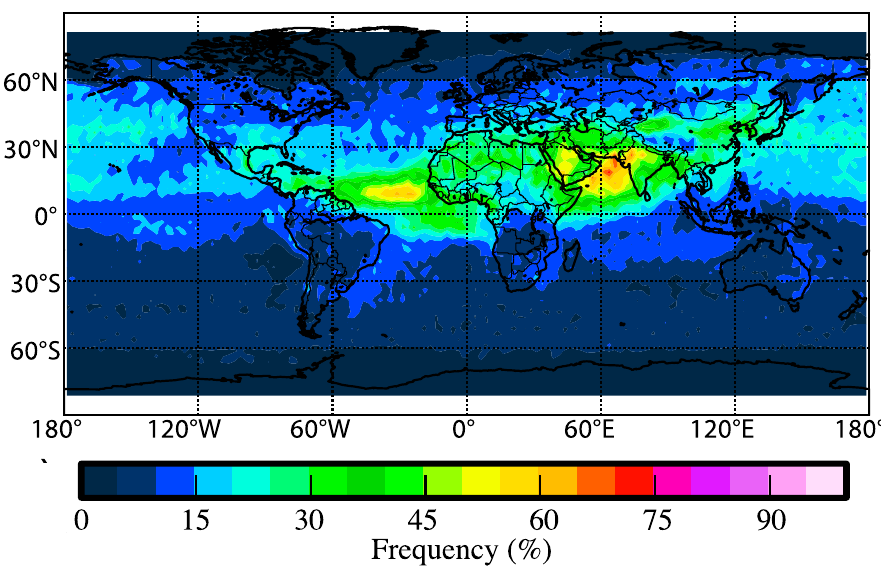
Figure 8. Global distribution of dusty clouds estimated from the combined CALIPSO/CloudSat observations from 2007 to 2010 in Spring.